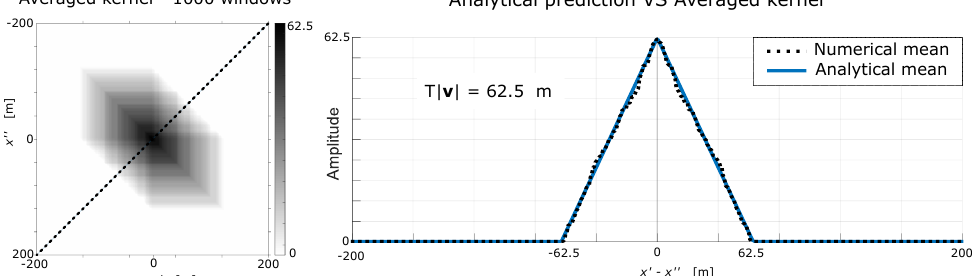
Figure 8. The structure of the kernel (cid:104) χχ (cid:105) T in Equation (24) of random windowing averaging (23) based on the uniform distribution of window locations. The kernel is given by a tent map (28) with height T | v | and width 2 T | v | , centered at x (cid:48) = x (cid:48)(cid:48) . The right panel shows the kernel parameterized in terms of the distance from the source locations x (cid:48) (for receiver x A ) and x (cid:48)(cid:48) (for receiver x B ) to the location of the source boundary with the receiver line (see the parametrization used in Figure 4); the analytical solution (28) is shown in blue and its approximation within the anti-diagonal section of the random windowing kernel (see the left panel) obtained via direct simulations is indicated by the dotted black line. The left panel shows the numerical approximation of the random window kernel based on 1000 windows for a single source train recording travelling at speed | v | = 25 m/s (90 km/h), with T = 2.5 s. Compare the structure of the above random windowing kernel (cid:104) χχ (cid:105) T with the stacking average kernel (cid:104) ˆ F ∗ ˆ F (cid:105) illustrated in Figure 4. Both kernels are present in the general retrieval